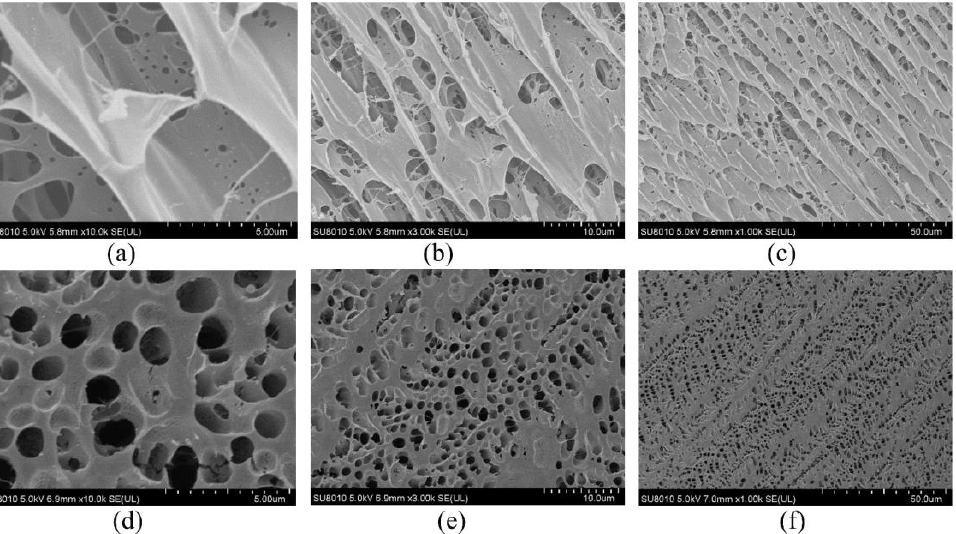
Figure 7. Cryo-SEM image of polymer gel: without nano-SiO 2 : ( a ) × 10.0 k; ( b ) × 3.0 k; ( c ) × 1.0 k; with 0.3 wt% nano-SiO 2 : ( d ) × 10.0 k; ( e ) × 3.0 k; ( f ) × 1.0 k.